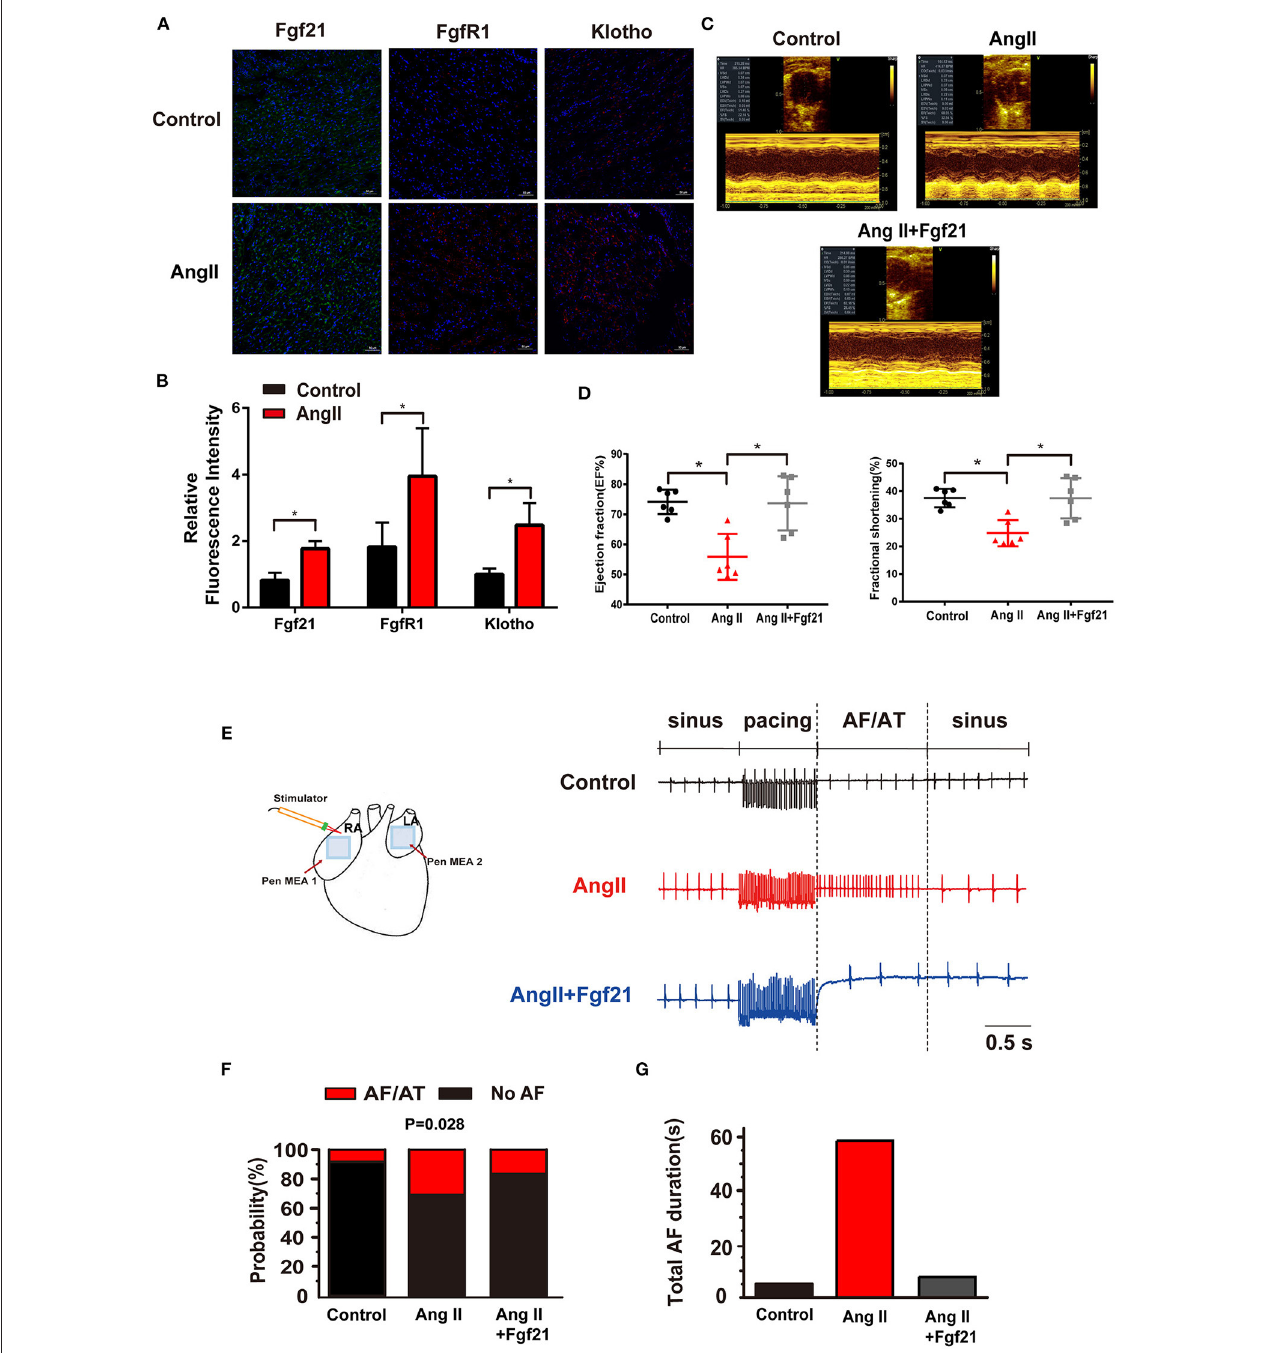
FIGURE 2 | Echocardiography and atrial electrophysiology in Ang II mice with or without treatment of Fgf21. (A) Representative immunofluorescence images of Fgf21, FgfR1, and β -Klotho in control and AngII-treated mice. (B) Summary of the relative fluorescence intensity of Fgf21, FgfR1, and β -Klotho in the atrial tissue of control and AngII-treated mice. (C) Representative M-mode images of each group: control, AngII, and AngII + Fgf21. (D) Summary of the effects of Fgf21 on ejection fraction and fractional shortening. (E) A schematic illustration of the experimental manipulation of electrical mapping. Representative extracellular potentials (ECP) of the atrium illustrate the induction of AF/AT in each group mouse following burst pacing in the right atrium. (F) Summary of inducibility of AF/AT in each group mouse. (G) Summary of total duration time of AF/AT in each group mouse that were induced into AF/AT. * p < 0.05, n = 6 mice per group.